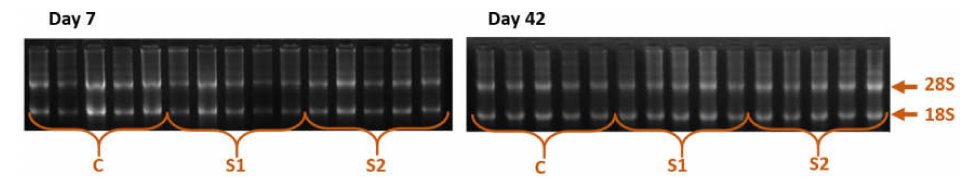
Figure 1. Assessment of RNA separation on 2% agarose gel. RNA was isolated from the pectoral muscle collected on days 7 and 42 from broiler chickens (3 groups per time point: C, S1, S2; n =